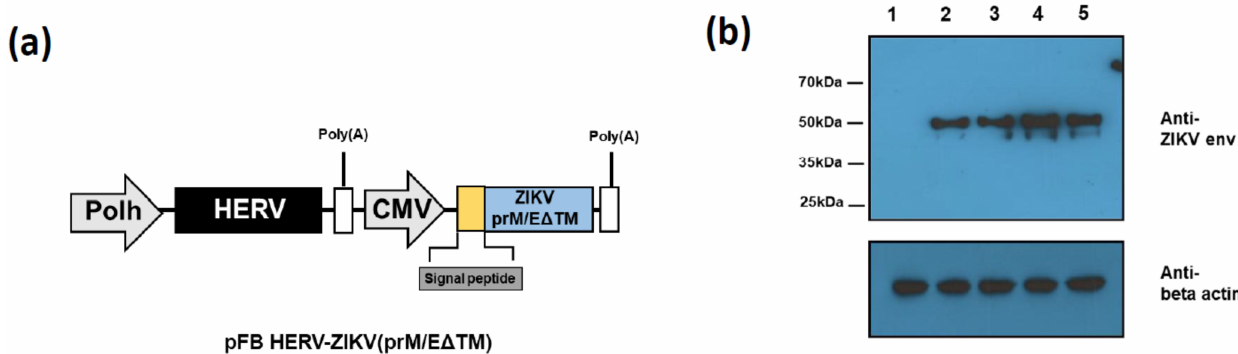
Figure 1. Generation of ZIKV prM/E-expressing baculovirus vectors regulated by different signal peptides. ( a ) Schematic diagram of recombinant ZIKV prM/E gene-delivering baculovirus vectors. ( b ) Expression levels of ZIKV prM/E controlled by various signal peptides. 293TT cells were infected with ZIKV prM/E-expressing baculoviruses regulated by signal sequences (SS) from different origins. Expression levels of prM/E were detected by Western blot analysis using anti- ZIKV ENV antibody. Lane 1, NTC; lane 2, AcHERV-ZIKV (prM/E ∆ TM with ZIKV SS); lane 3, AcHERV-ZIKV (CD5 SS-prM/E ∆ TM); lane 4, AcHERV-ZIKV (IgK_SS-prM/E ∆ TM); lane 5, AcHERV-ZIKV (IgM_SS-prM/E ∆